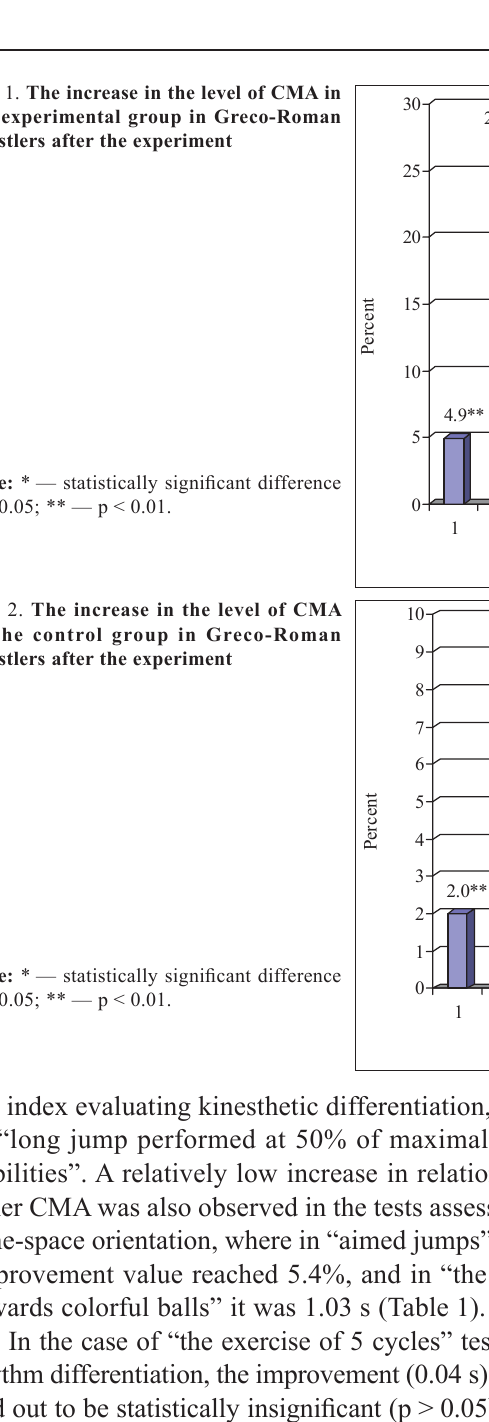
Fig. 1. The increase in the level of CMA in the experimental group in Greco-Roman wrestlers after the experiment